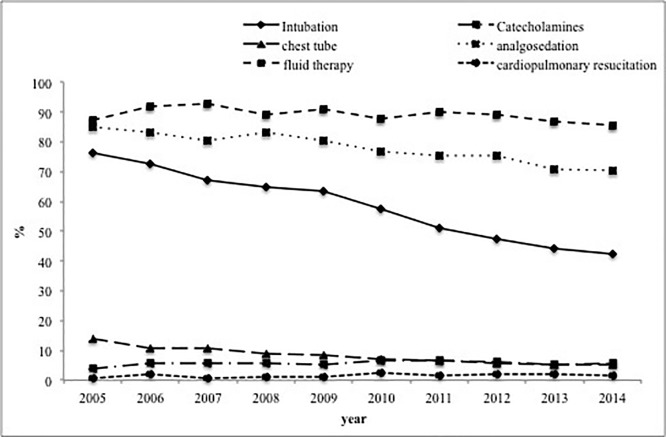
Therapeutic intervention at hospital admission in primarily admitted patients per year between 2005 and 2014.